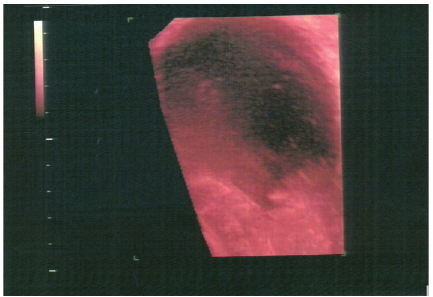
Figure 2: Three-dimensional image of a dermoid cyst. The hyperechoic solid part and speckled appearance of the sebaceous contents are seen with the use of minimum maximum mode.